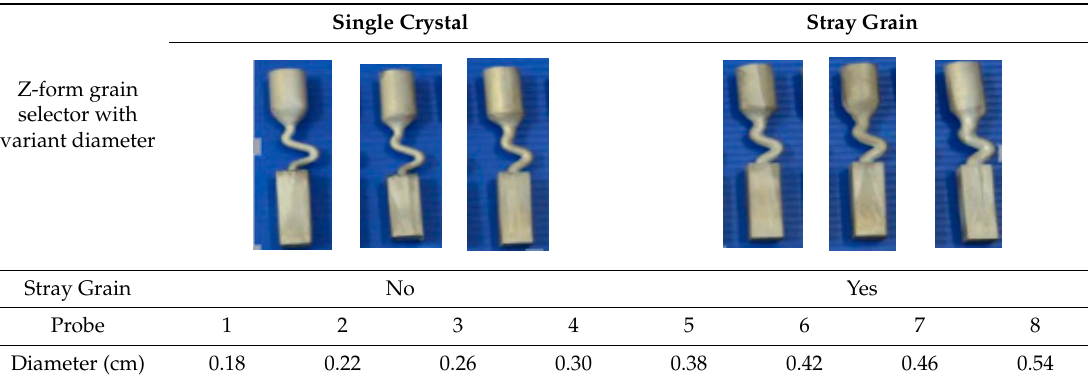
Table 3. Variation in the thickness of the grain selector portion: Group 1.